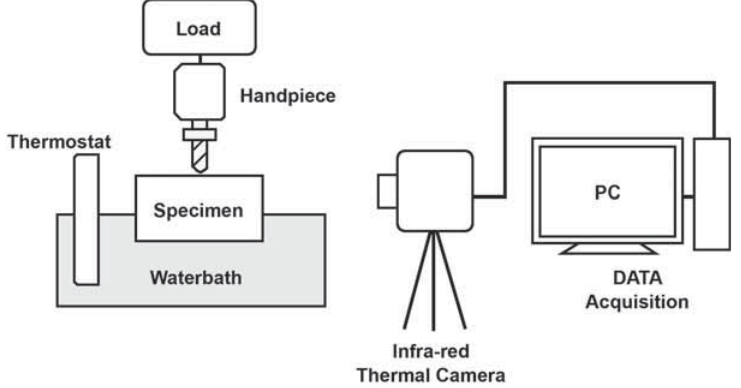
Figure 3- Schematic diagram of the experimental system